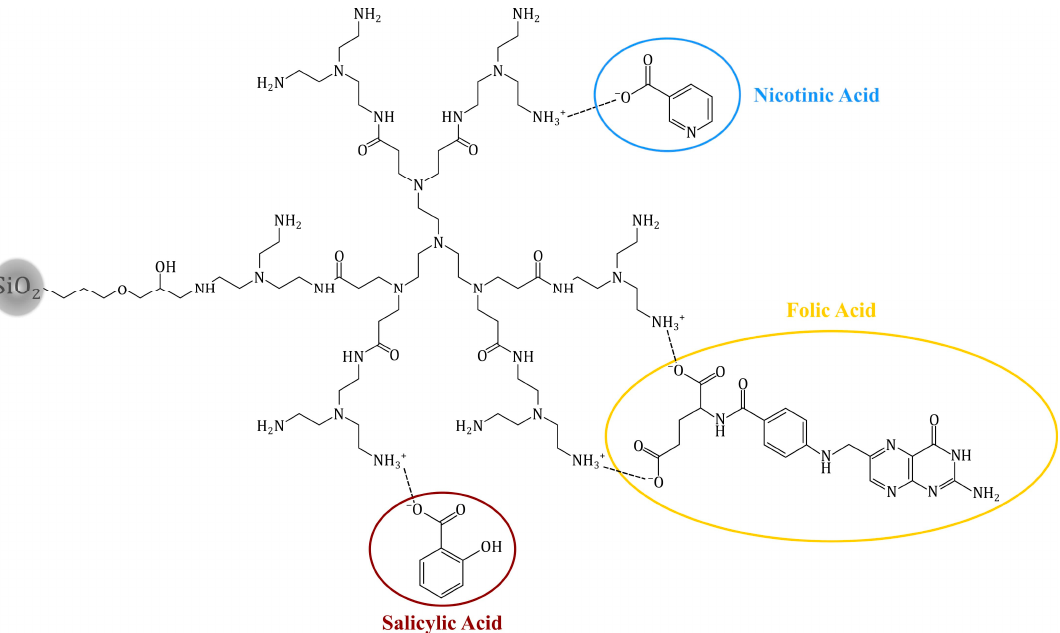
Figure 4. The possible electrostatic interactions (dotted line) between the PAMAM-grafted silica particles and bioactive compounds, the example of SiO 2 -TREN material.